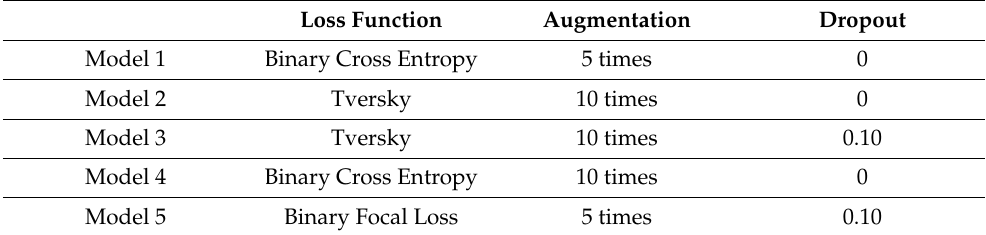
Table 1. The detail of the ensembled model for infection